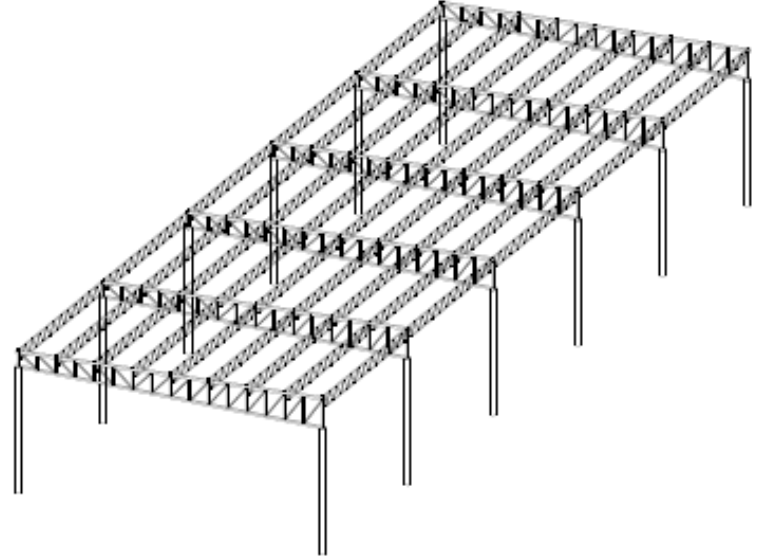
Figure 3. Spatial view of the analyzed structure [25].